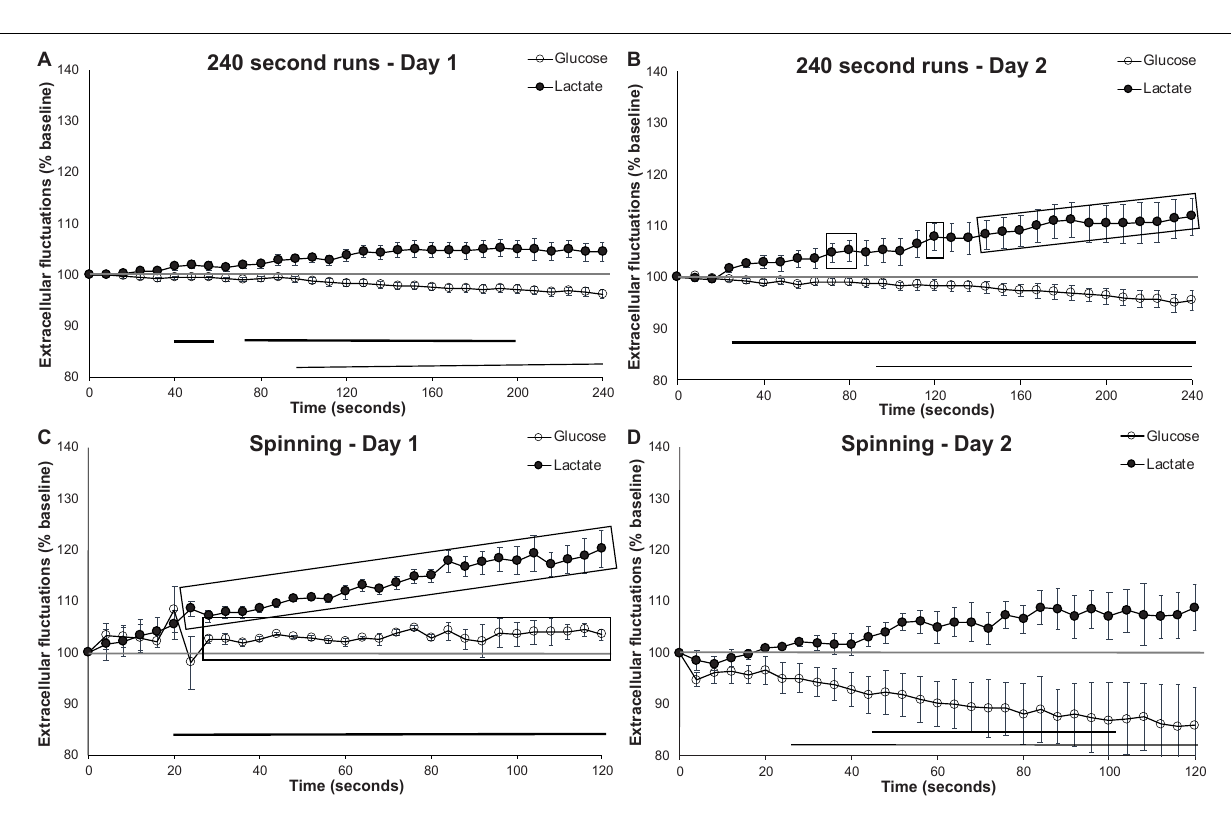
Frontiers in Neuroscience |